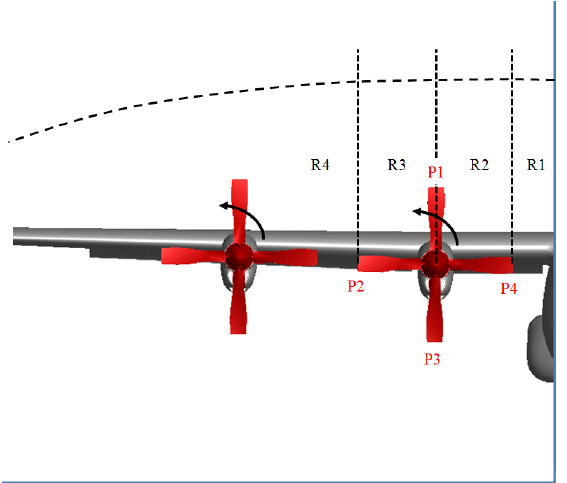
Figure 1. Propeller wing interference effects for counterclockwise spinning propeller of